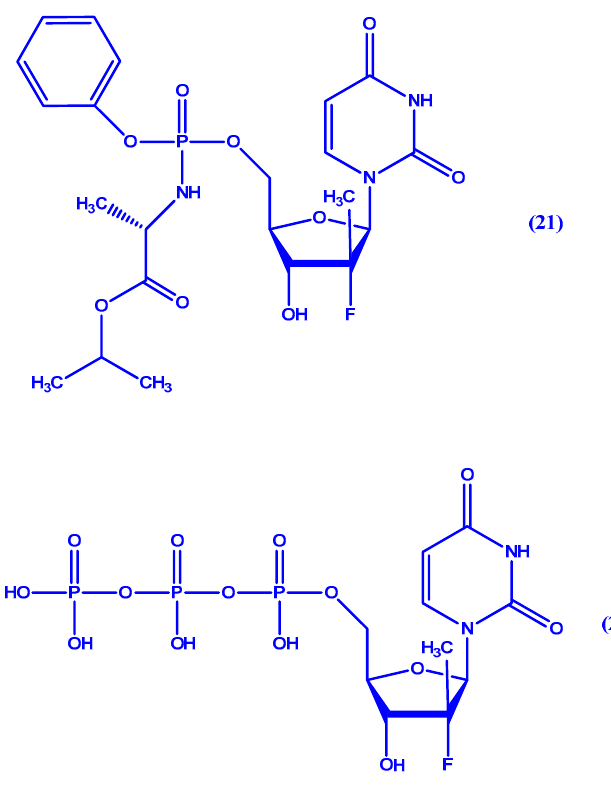
Figure 11. Chemical structure of sofosbuvir ( 21 ) and its active form 22 .